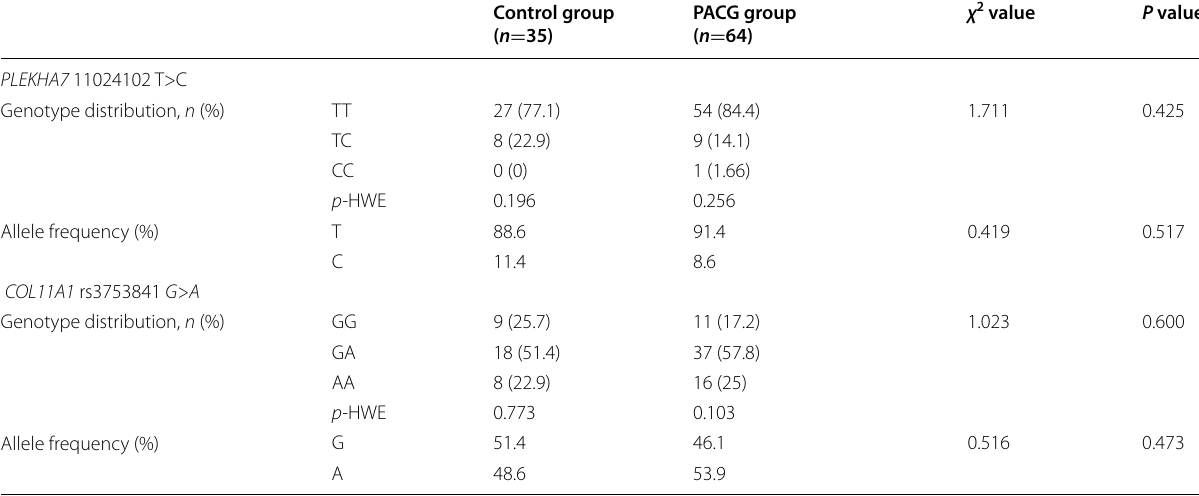
Data are expressed as frequencies